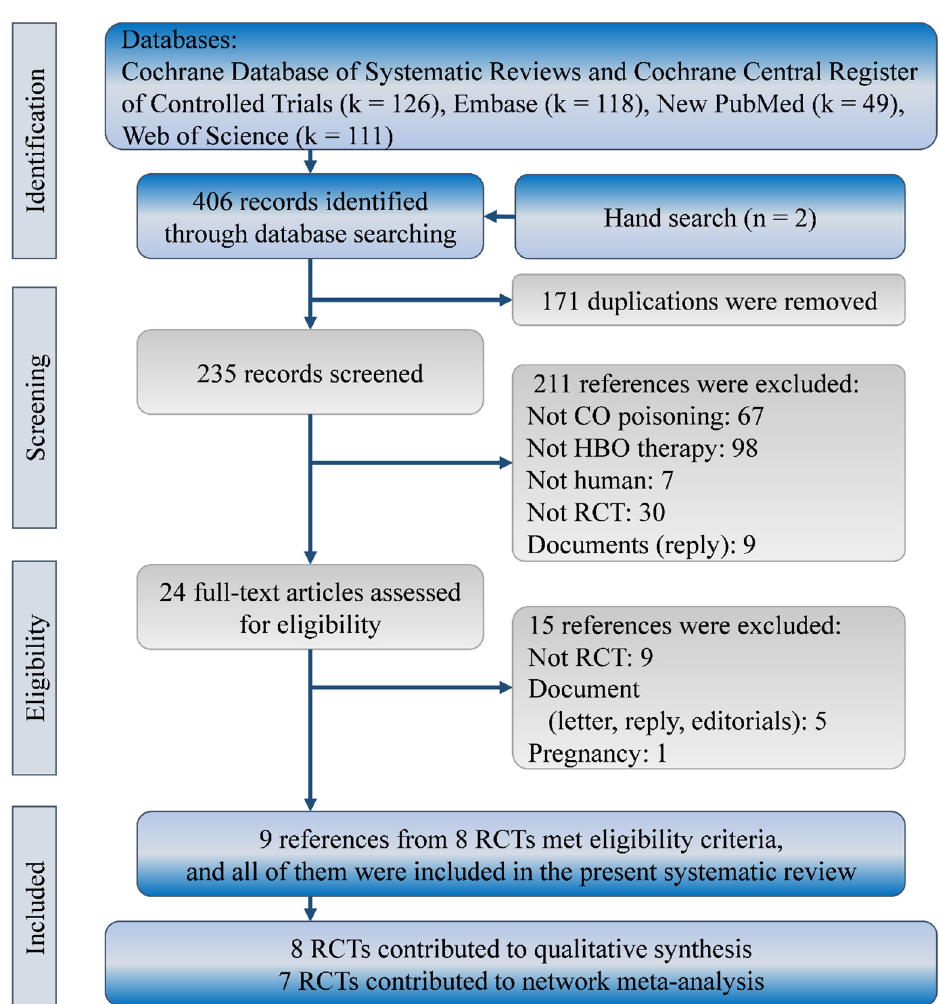
Figure 1. Flow diagram of study selection. RCT, randomized clinical trial.